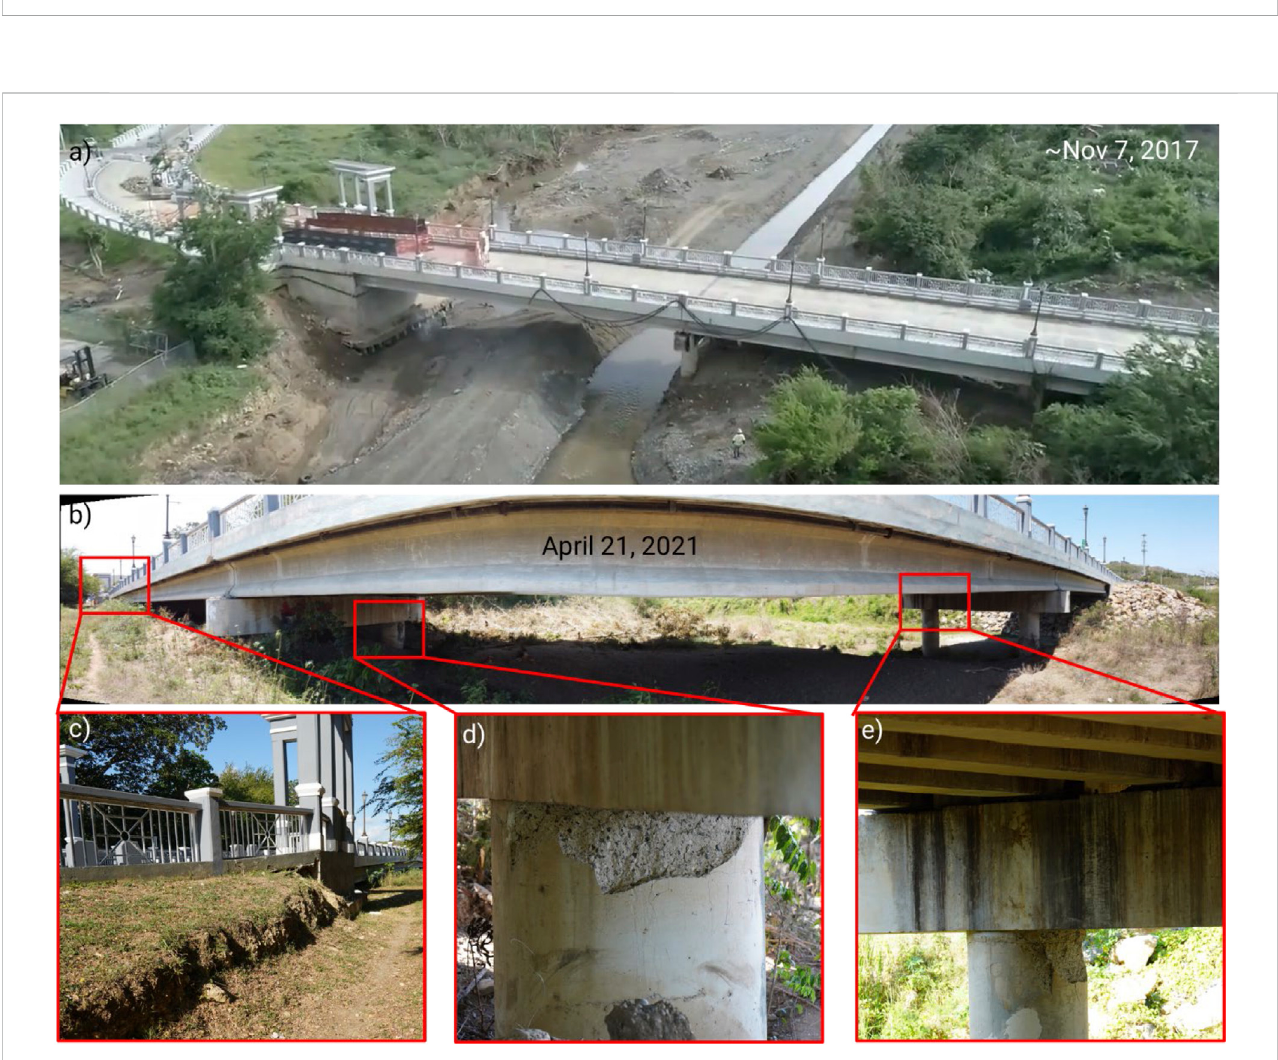
FIGURE 9 Bridgein Guayanilla, PRover theGuayanilla River.These photos include (A) ascreenshot froma drone fl yover taken 50days after hurricaneMaria (Maria, 2017), (B) an overall view of the bridge taken on the fi nal reconnaissance mission, (C) the geotechnical impacts observed at the abutment, (D) cracking on support column on Pier 1, and (E) cracking of support column on Pier